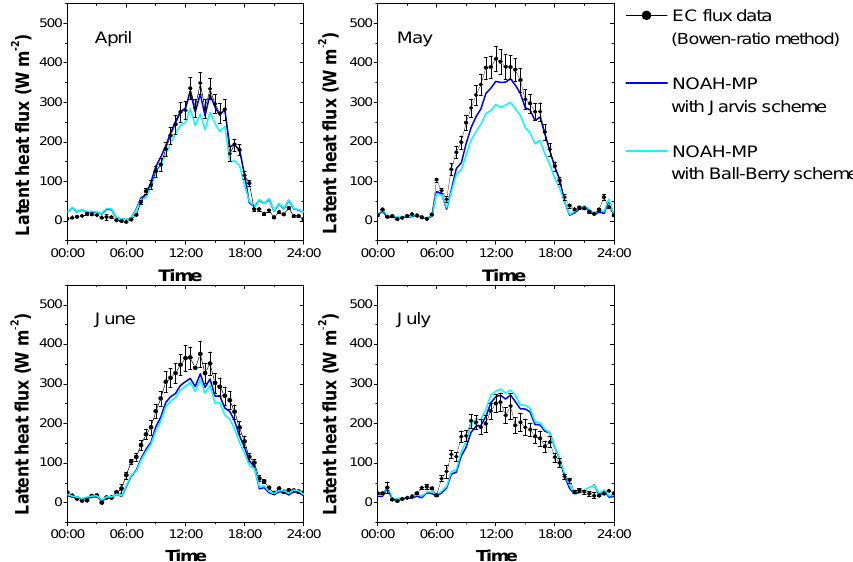
Figure 5. State-of-the art approach to compare simulated and measured eddy covariance (EC) flux data. The monthly average cycles of latent heat flux were computed based on Bowen ratio post-closed data. For modelling, the NOAH-MP land surface model was used in two configurations. The stomatal resistance was computed either with the empirical Jarvis scheme or the photosynthesis-based Ball–Berry scheme. The simulated fluxes are compared with measured EC flux data that were adjusted with the Bowen ratio method. The error bars indicate the random measurement error. In some cases, the error bars are smaller than the size of the symbol and therefore not visible.